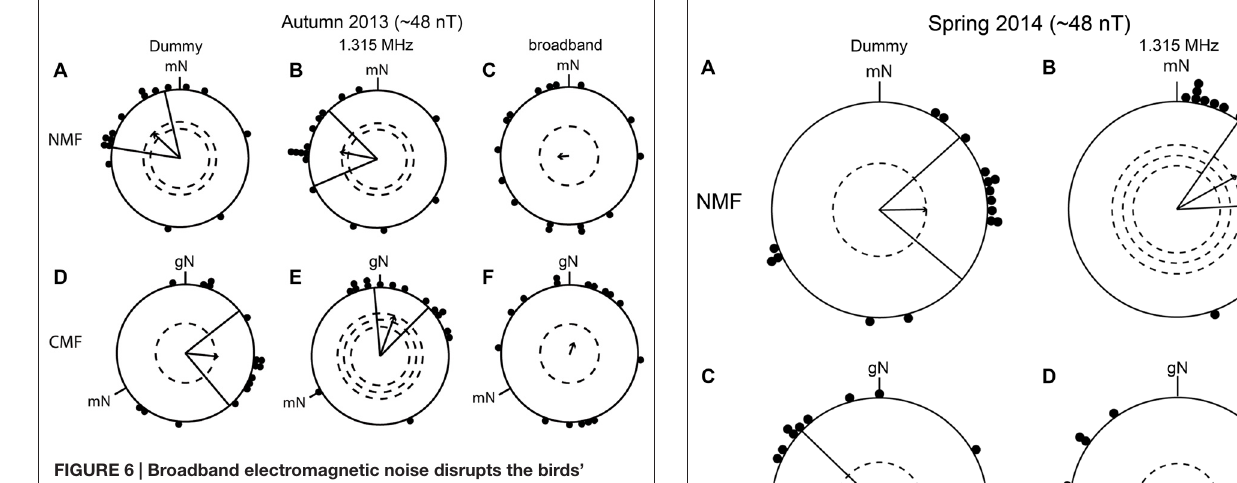
FIGURE 6 | Broadband electromagnetic noise disrupts the birds’ magnetic orientation capabilities whereas a narrow-band field at 1.315 MHz does not . The birds were able to orient in the dummy condition in the natural geomagnetic field (NMF), (A) , mean direction 313 ◦ ± 34 ◦ , r = 0.54, p < 0.01, N = 16 and the changed magnetic field (CMF), (D) , mean direction 96 ◦ ± 44 ◦ , r = 0.49, p < 0.05, N = 16 and when exposed to 1.315 MHz (NMF, (B) , mean direction 281 ◦ ± 34 ◦ , r = 0.56, p < 0.01, N = 16; CMF, (E) , 1.315 MHz: mean direction 20 ◦ ± 25 ◦ , r = 0.62, p < 0.001, N = 16). In contrast, the same birds were disoriented when exposed to artificial broadband noise ( ∼ 2 kHz to ∼ 9 MHz), NMF: (C) , mean direction 265 ◦ , r = 0.17, p = 0.603, N = 16; CMF: (F) , 21 ◦ , r = 0.19, p = 0.557, N = 16. All experiments were done in autumn 2013. For a description of the circular diagrams, see the legend to Figure 5 . gN, geographic North.